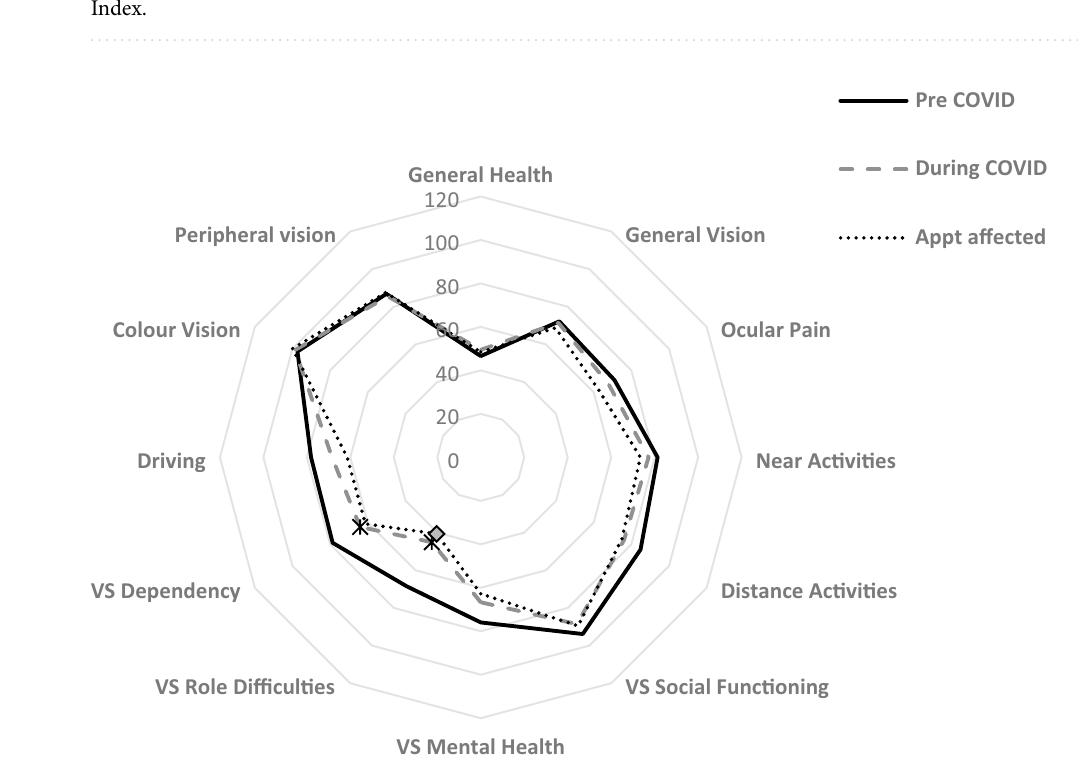
Figure 1. Comparison of pre COVID-19 and during COVID-19 overall ( A ) OSDI scores and ( B ) overall ESSPRI scores. OSDI, Ocular Surface Disease Index; ESSPRI, EULAR Sjögren’s Syndrome Patient Reported Index.